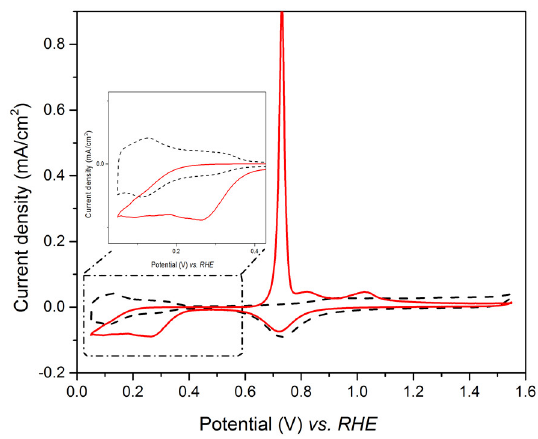
Figure 3. Steady-state voltammetric response of the Pt electrode in 0.1 M HClO 4 (dotted line) and first cycle profile after Pt electrode polarization in 1 mM TeO 2 for 450 s at 0.35 V vs. RHE (full line), sweep rate = 40 mV/s.